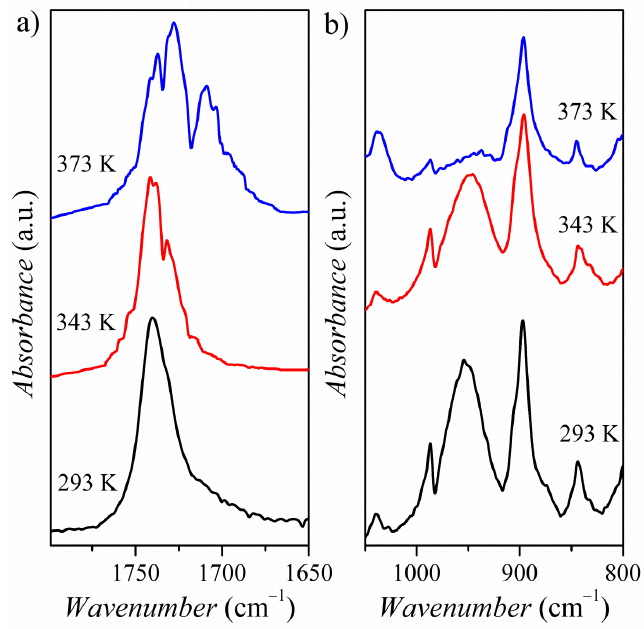
Figure 11. FT-IR absorption spectra of the PyrHem×H 2 O at 293, 343, and 373 K in spectral ranges: 1800–1650 cm − 1 ( a ) and 1100–800 cm − 1 ( b ).